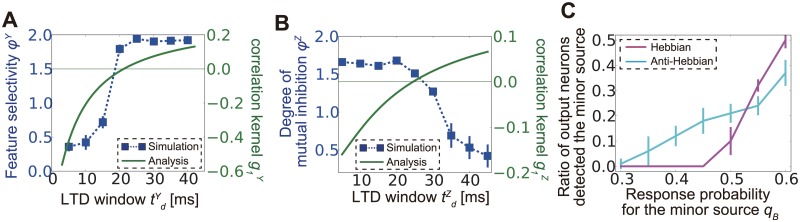
Correlation propagation shapes lateral connection structure.(A) Comparison between feature selectivity ϕY (blue dots) calculated from simulation results and analytically calculated correlation kernel function g
1
Y (green line) for lateral excitatory connections. Thin green horizontal line represents g
1
Y = 0. (B) Comparison between the degree of mutual inhibition ϕY (blue dots) calculated from the simulation and analytically calculated correlation kernel g
1
Z (green line) for lateral inhibitory connections. Negative g
1
Z is correlated with a high degree of mutual inhibition, as expected (see Methods). (C) Ratio of output neurons tuned for the minor source in a minor source detection task under Hebbian and anti-Hebbian inhibitory spike-timing-dependent plasticity.